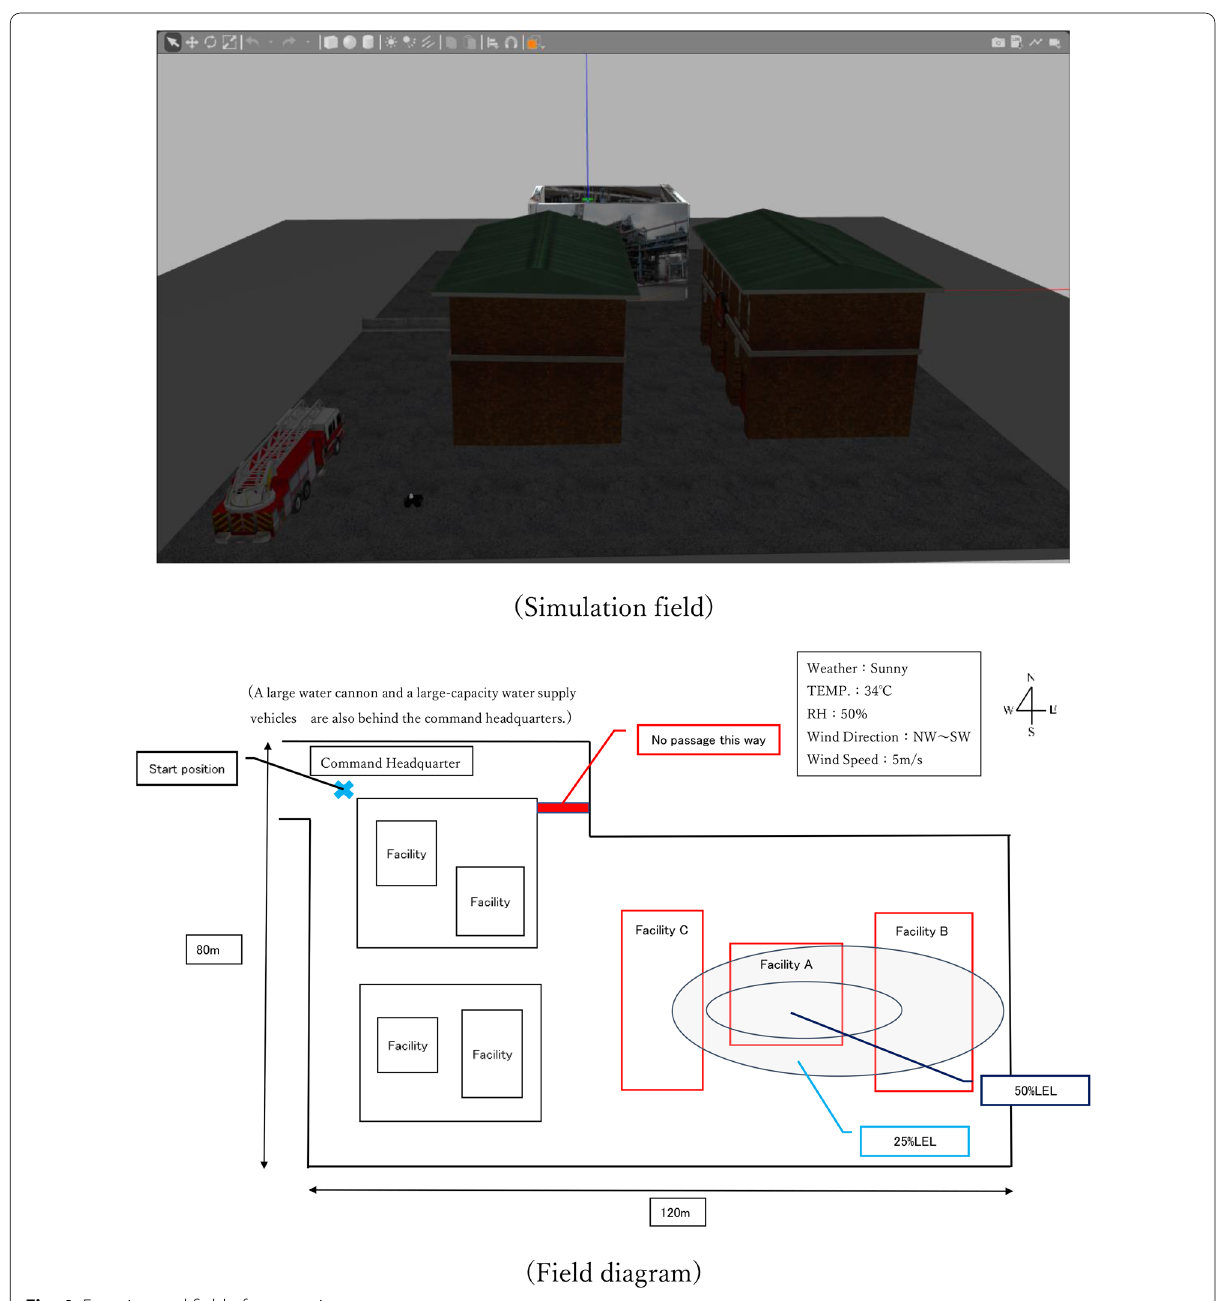
Fig. 4 Experimental field of